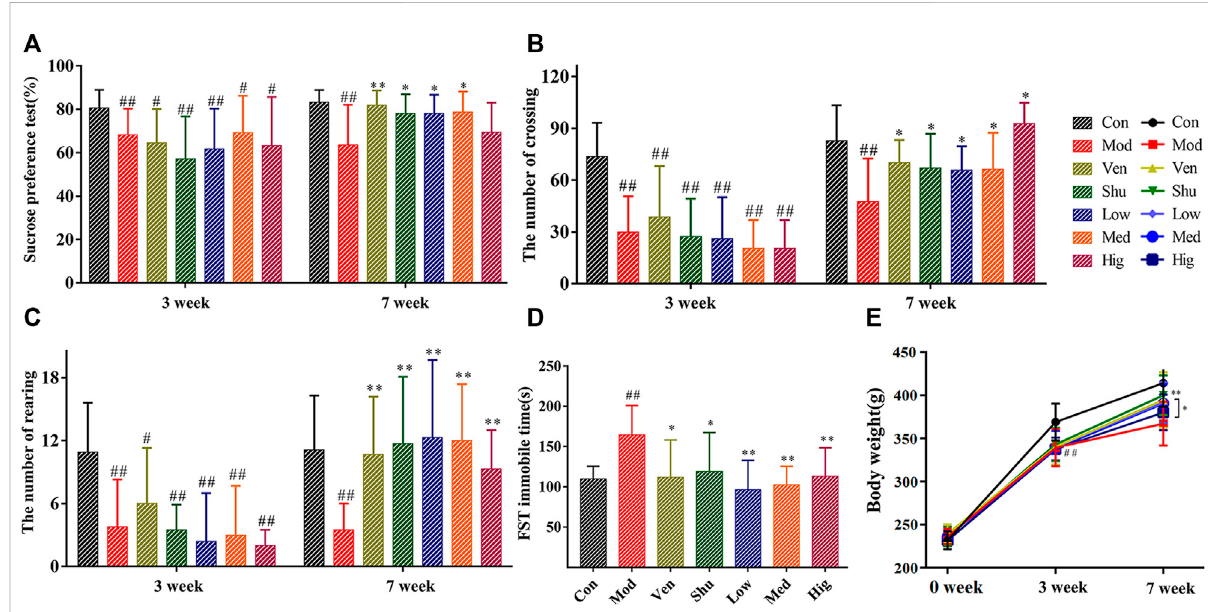
FIGURE 2 TheeffectofChaiguigranuleonbehavior. (A) Sucrosepreference(%). (B) Thenumberofcrossings. (C) Thenumberofrearing. (D) Immobiletimeof FST. (E) Bodyweight(g).Alldatawereexpressedasmean±SD. # p < 0.05, ## p < 0.01comparedwithControlgroup. ✻ p < 0.05, ✻✻ p < 0.01comparedwith Model